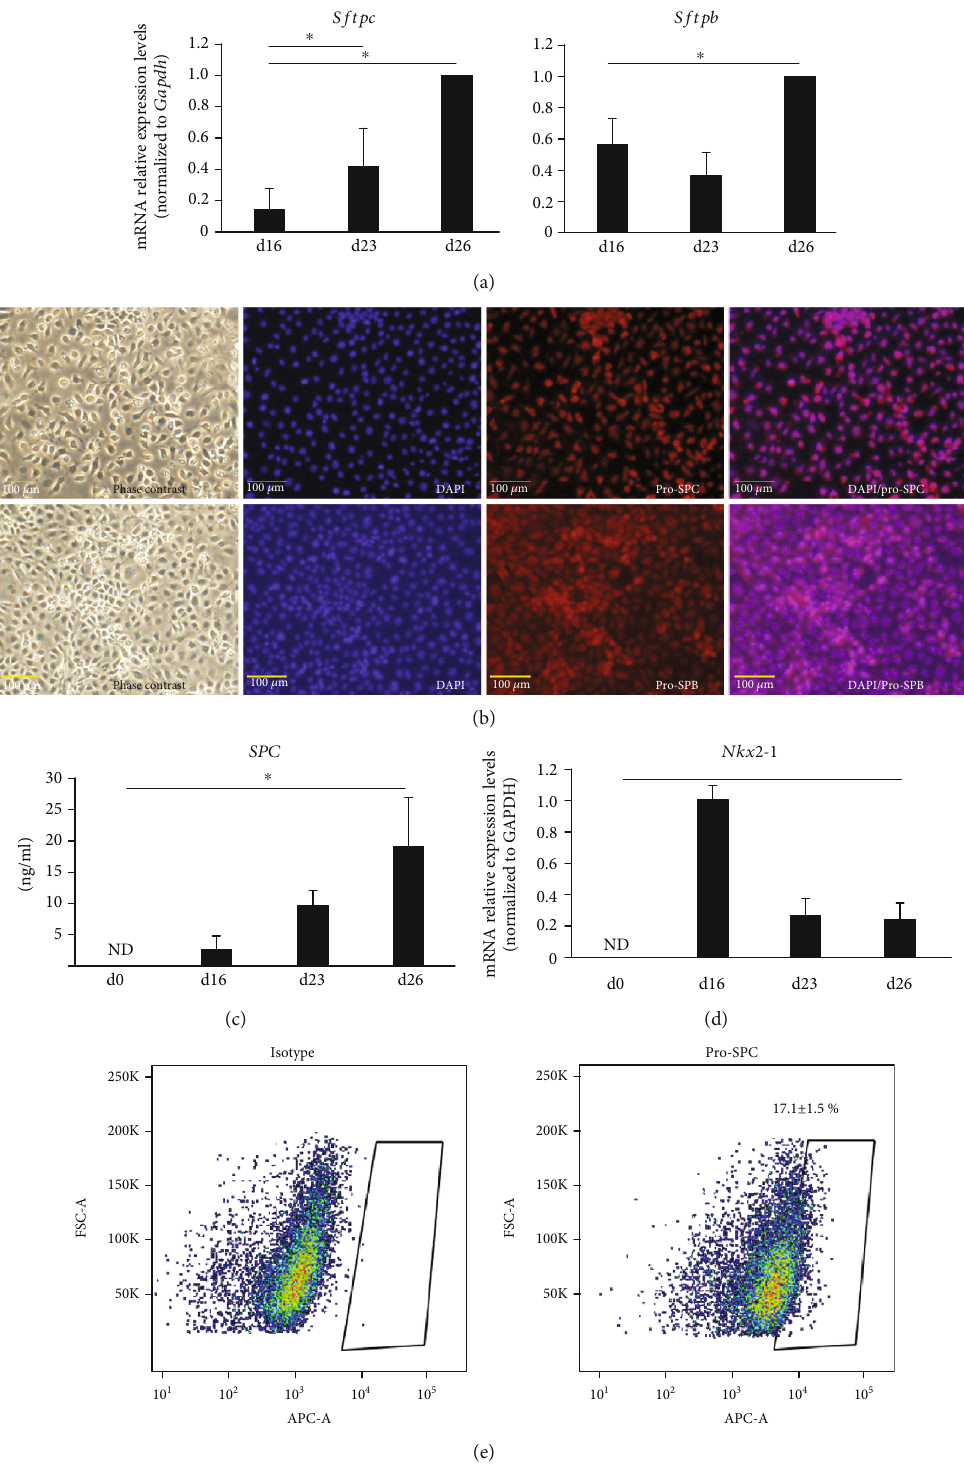
Figure 3: (a) Quantitative polymerase chain reaction analysis of ATII (day 26) ( n = 5 ). Expressions of Sftpc and Sftpb mRNA. Expression ratios were normalized to the level of Gapdh expression. Expression levels were compared with those of ATII (day 26). ∗ P < 0 : 05 . (b) Phase-contrast image and immuno fl uorescence images of pro-SPC and pro-/mature SPB in ATII (day 26). Scale bars: 100 μ m. (c) Enzyme-linked immunosorbent assay of SPC in culture supernatant ( n = 3 ). ∗ P < 0 : 05 . ND: not detected. (d) Quantitative polymerase chain reaction analysis of ATII (day 26) ( n = 3 ). Expressions of Nkx2-1 mRNA. Expression ratios were normalized to the level of Gapdh expression. Expression levels were compared with those of VAFE (day 16). ND: not detected. (e) Flow cytometry analysis of pro-SPC in ATII (day